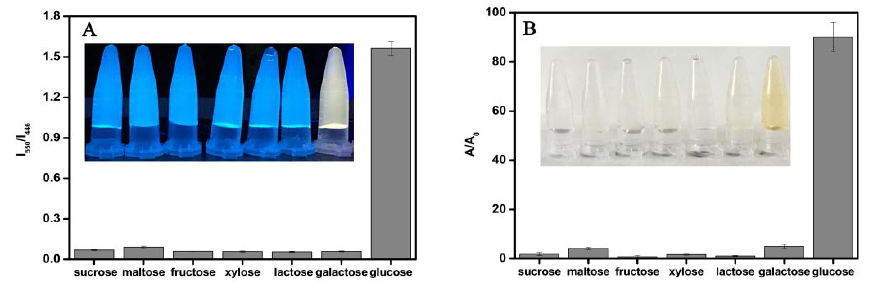
Figure 5. The interference experiments of glucose structure analogues to glucose using: ( A ) Ratiometric fluorescence and ( B ) a colorimetric method (the interferents’ concentration is 2 mM; the glucose concentration is 200 μM).